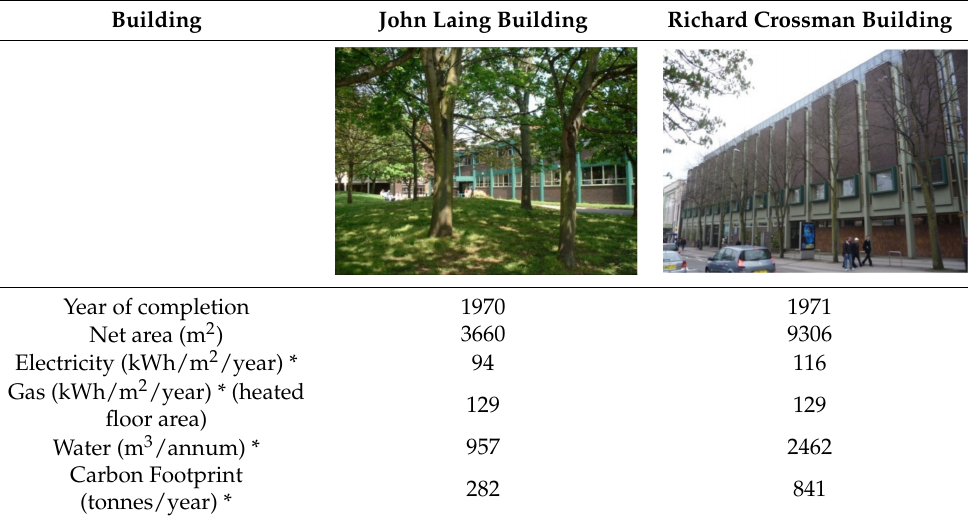
Table 1. Building